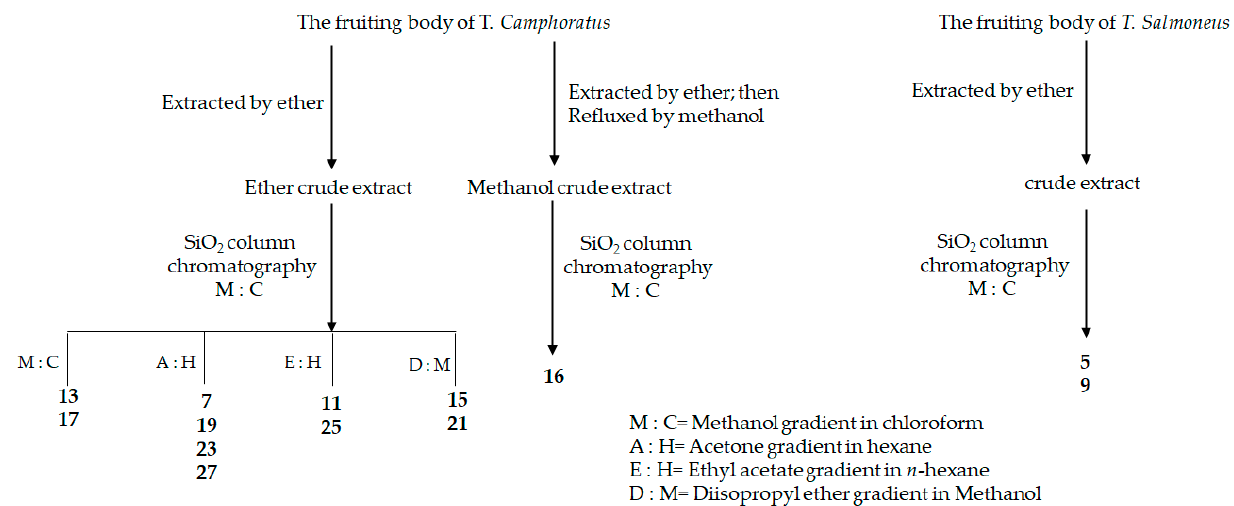
Figure 2. Isolation flow chart for zhankuic acid-type compounds. Table 1. Name and reference of zhankuic acid-type compounds.